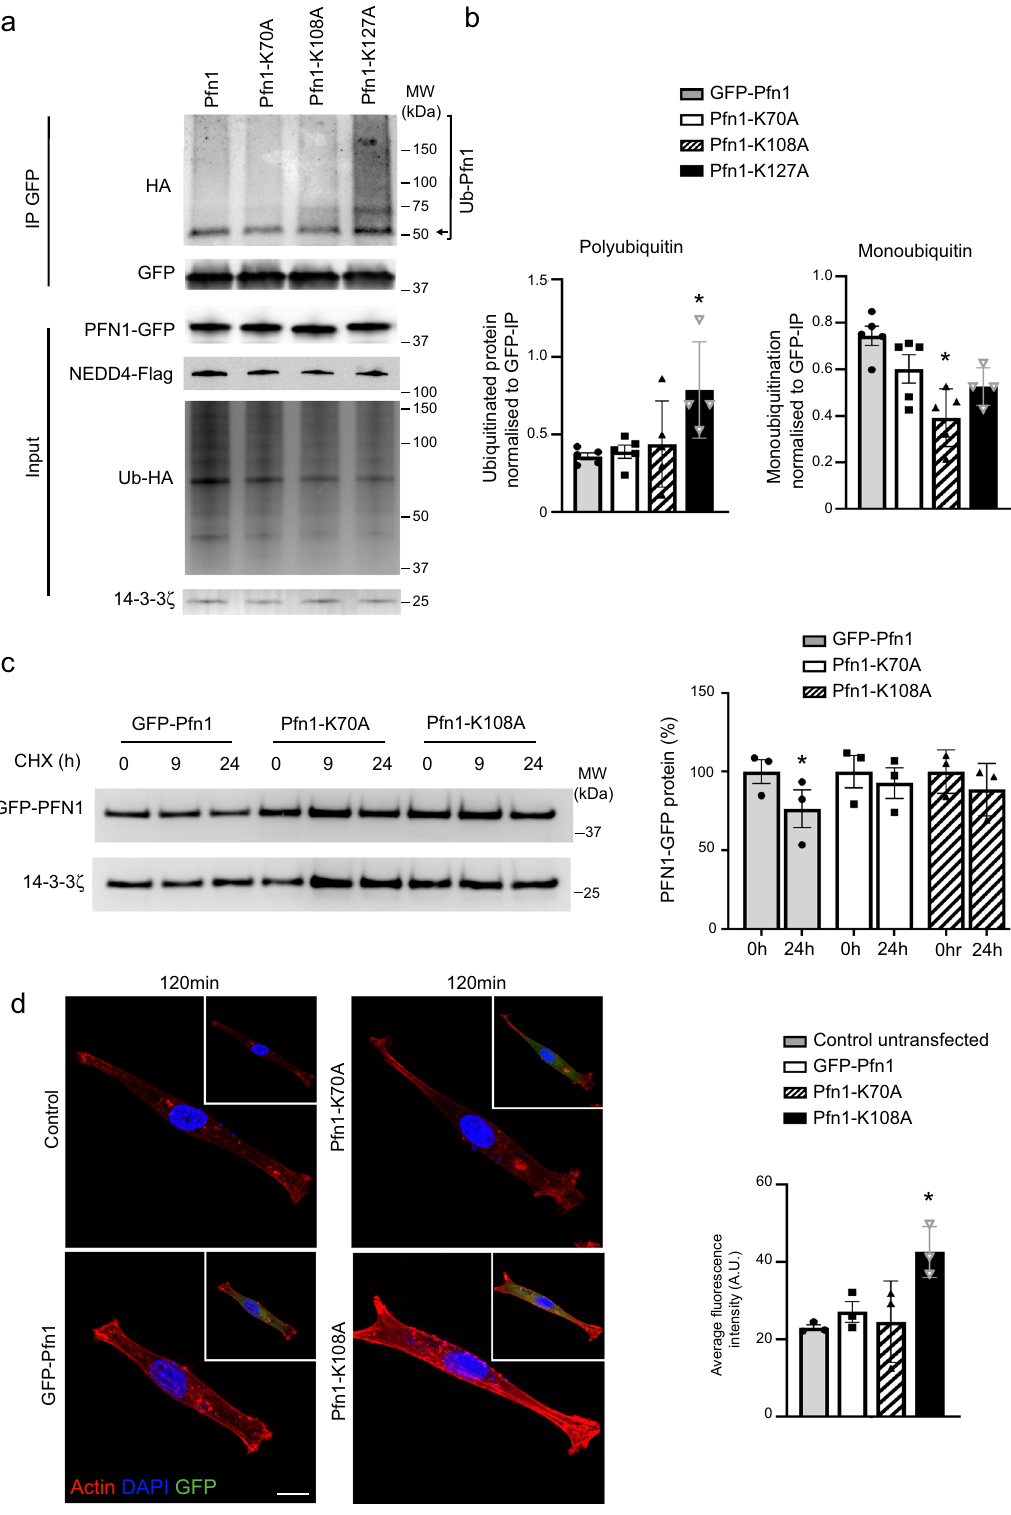
bone formation. Critical roles for the actin cytoskeleton have been identi fi ed in the regulation of core NCC transcription factors 56 , NCC delamination 57 , NCC migration 58 and in craniofacial morphogenesis 59 . Consistent with at least part of the Nedd4 − / − NCC defect arising from alterations to actin polymerisation, morpholino knockdown of the actin-depolymerizing factor (ADF) in chick also had pronounced effects on SOX10